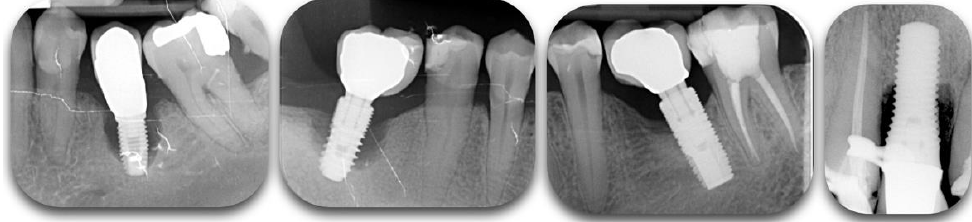
Figure 2. Radiographic films showing different degrees of peri-implant bone loss. The change of contrast can make the defect difficult to categorize.